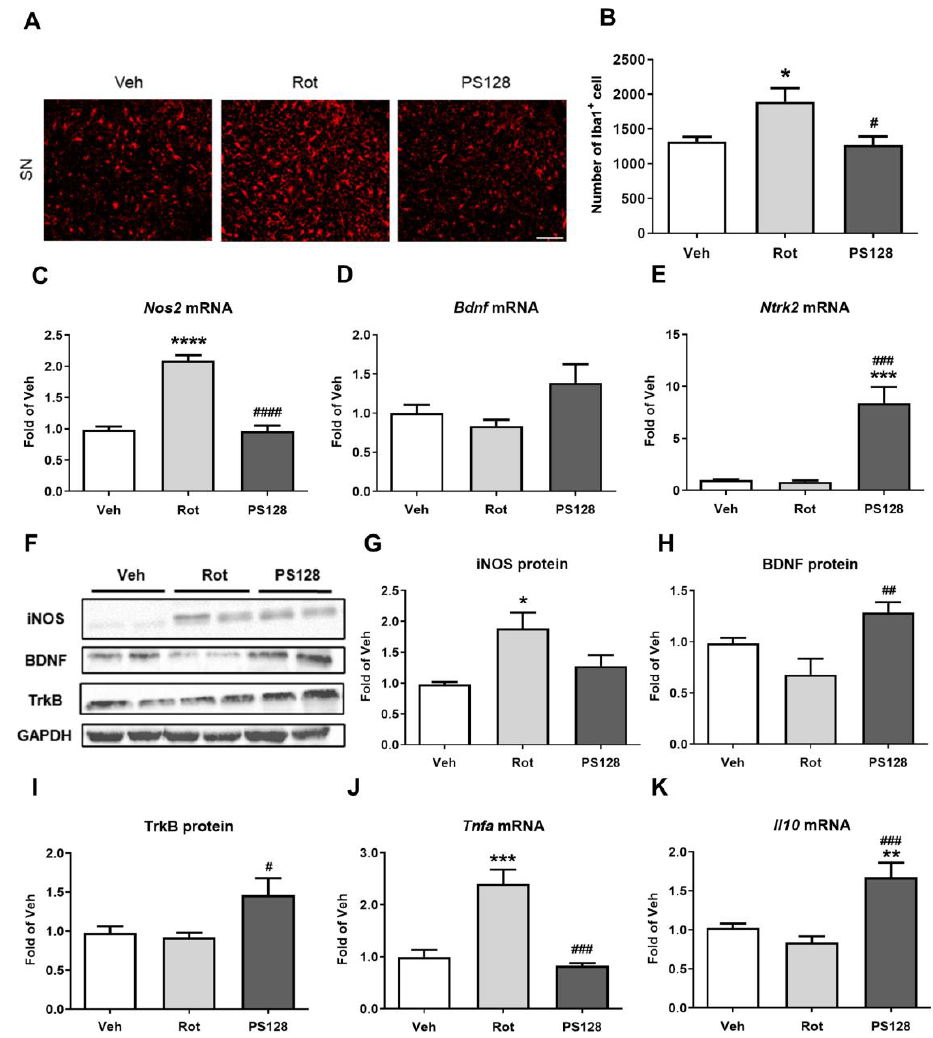
Figure 3. Effects of L. plantarum PS128 on rotenone-induced microglial activation, neurotrophic factor, and inflammation in the brain. ( A ) Representative images of ionized calcium-binding adaptor molecule-1 (Iba1) immunostaining in the SN. ( B ) Quantitative analysis of Iba1 + cells in the SN of mice. ( C – E ) The levels of gene expression of nitric oxide synthase 2 ( Nos2 ), brain-derived neurotrophic factor ( Bdnf ), and neurotrophic receptor tyrosine kinase 2 ( Ntrk2 ) in the midbrain. ( F ) Representative blots of inducible nitric oxide synthase (iNOS), BDNF, and tropomyosin receptor kinase B (TrkB) in the midbrain. ( G – I ) Quantitative analysis of iNOS, BDNF, and TrkB blots. ( J , K ) The gene expression levels of tumor necrosis factor-alpha ( Tnfa ) and interleukin-10 ( Il10 ). N = 5 per group, * p < 0.05, ** p < 0.01, *** p < 0.001, **** p < 0.0001 compared with the Veh group; # p < 0.05, ## p < 0.01, ### p < 0.001, #### p < 0.0001 compared with the Rot group. Scale bar = 100 μm in ( A ).